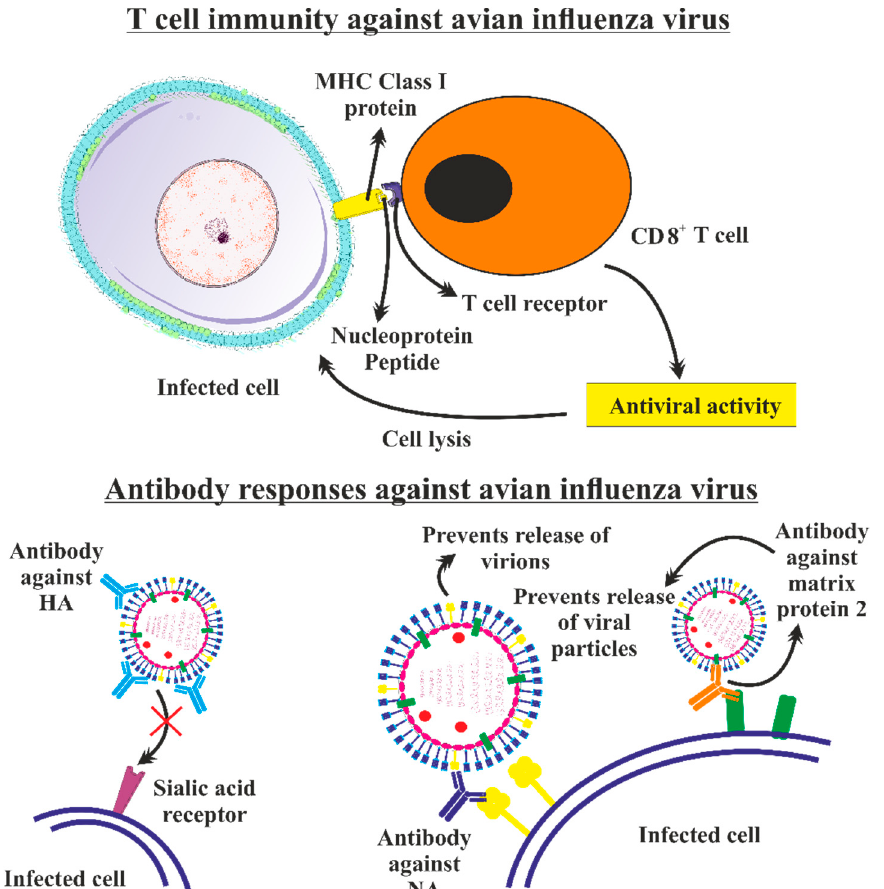
Figure 8. When CD8 + T cells with specificity for viral proteins such as nucleoprotein (NP) or the RNA polymerase proteins such as polymerase basic protein 2 (PB2) and polymerase acidic protein (PA) recognize viral peptides presented by MHC class I molecules, which leads to the release of cytokines with antiviral activity that mediate cytolysis of the infected cell; HA-specific antibodies stop the fusion of cells or impede viral attachment, thus preventing cell infection; NA-specific antibodies attach the virus to the cell and circumvent the release of virions; M2-specific antibodies attach virus to the cell and stop viral particles from escaping into the extracellular fluid.